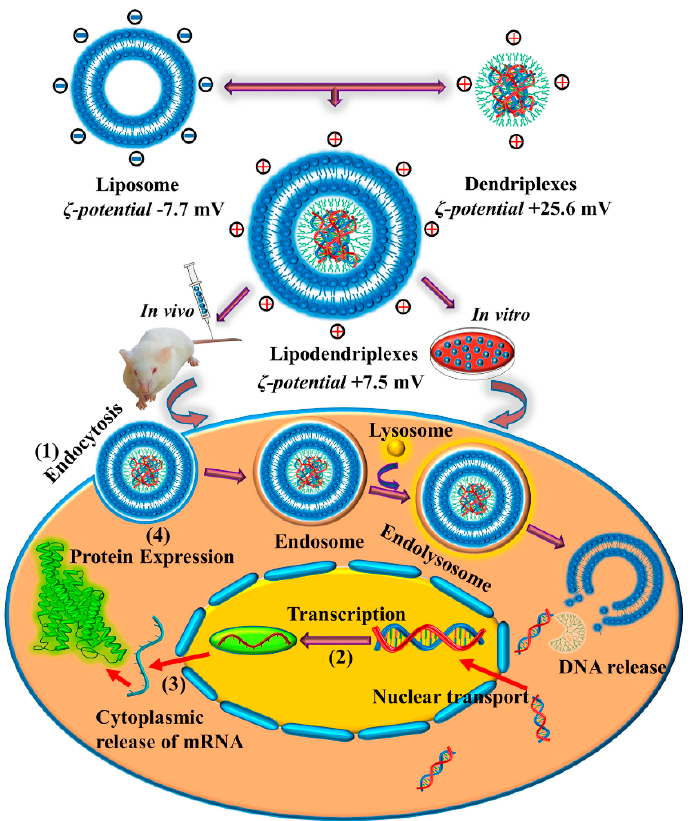
Figure 6. Schematic representation of lipodendriplexes formation and cellular internalization. ( 1 ) Endocytosis and pDNA release into the cytoplasm. ( 2 ) Transcription of gene-encoded DNA into mRNA. ( 3 ) mRNA export from the nucleus to the cytoplasm. ( 4 ) Protein expression. Adapted from [136], published by Nature, 2020.